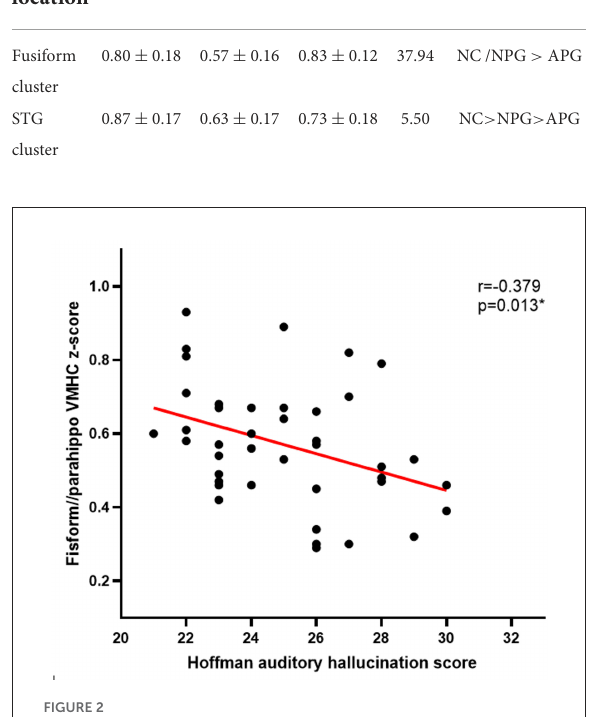
FIGURE2 The Hoffman score was negatively correlated with the VMHC in the fusiform cluster in APG ( p < 0.05).